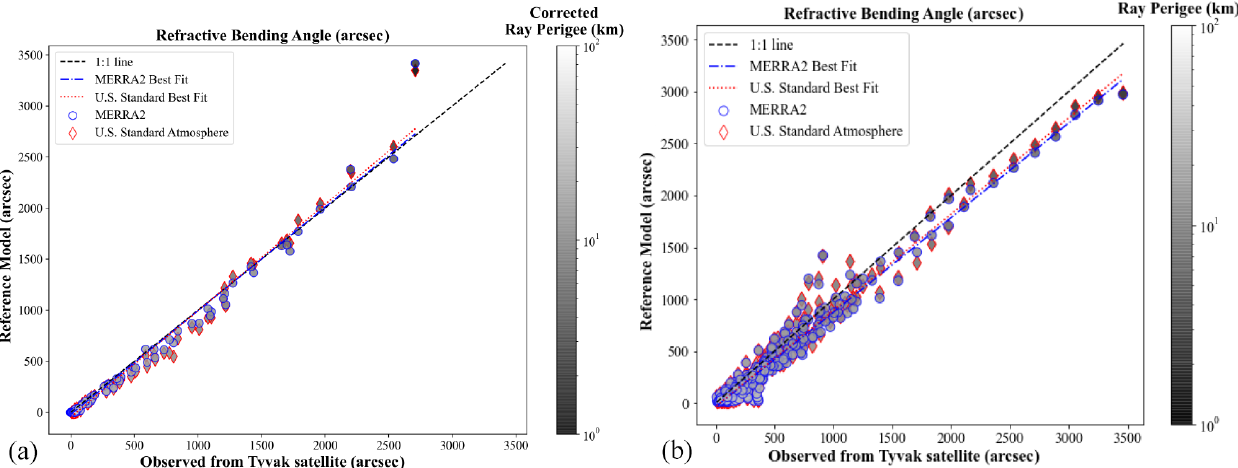
Figure C2. Parity plot of the US Standard and MERRA2 reference model predictions against the observed bending angle from star tracker and GEOStare SV2 in panels (a) and (b) , respectively. The ray perigee of each point is shown in the grayscale color bar.